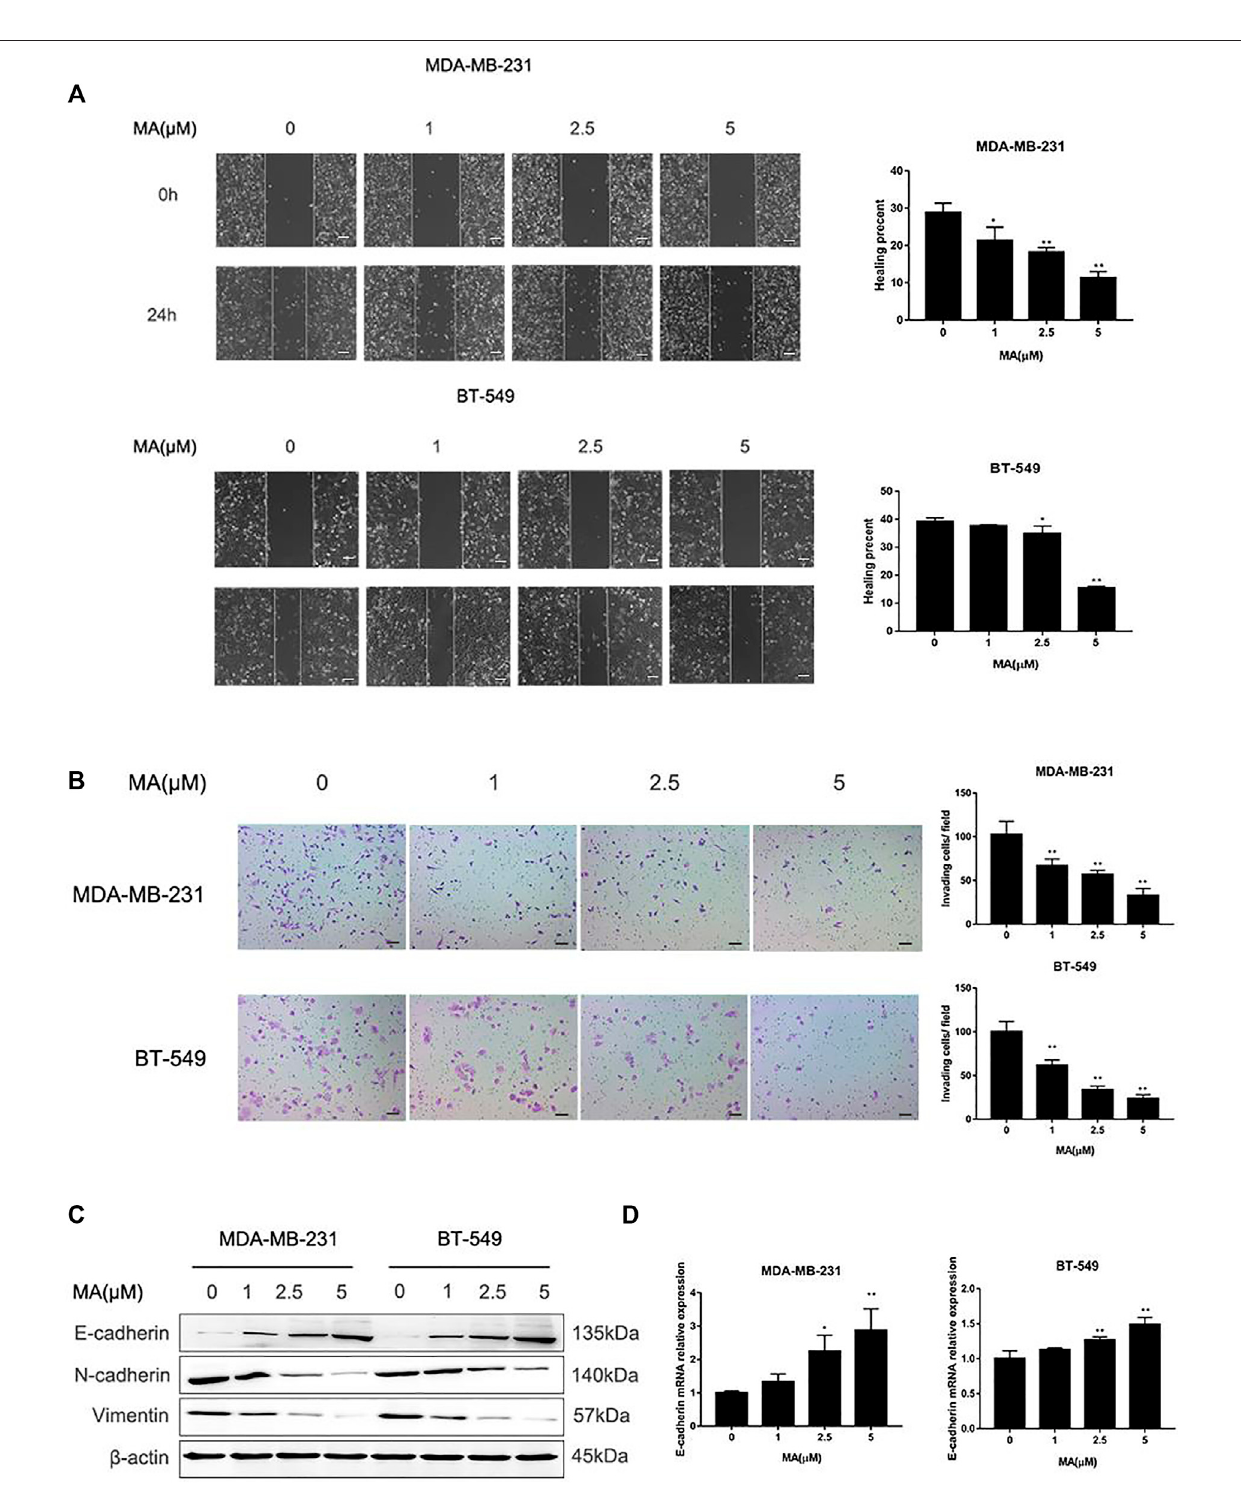
FIGURE4| MAalleviatesmigrationandinvasionofTNBCcells. (A) RepresentativeimagesofwoundhealingassayandhealingpercentageofTNBCcellsafter24 h MA treatment. (B) Representative images of chamber invasion assay and number of invading cells after 24 h MA treatment. (C) Western blot analysis of EMT-related protein levels after 24 h MA intervention. (D) Real-time PCR analysis of E-cadherin after exposure to MA for 24 h. Compared with the control group (0 μ M), * p < 0.05, ** p < 0.01.